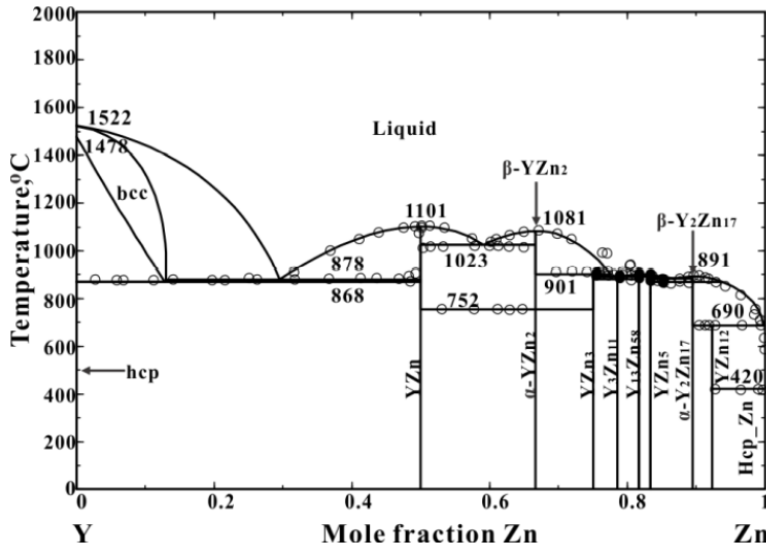
Figure 1. Yttrium–zinc phase diagram [109].